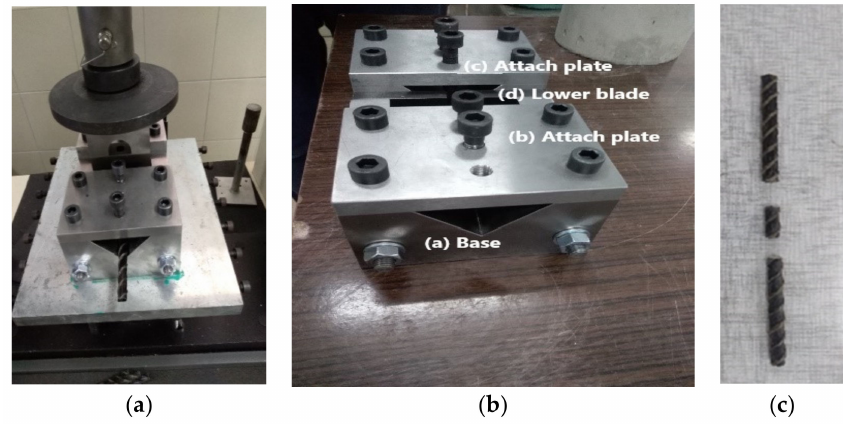
Figure 5. ( a ) Double shear testing device, Instron 3382, ( b ) Description of Instron 3382 testing machine, ( c ) Shear failure of the FRP